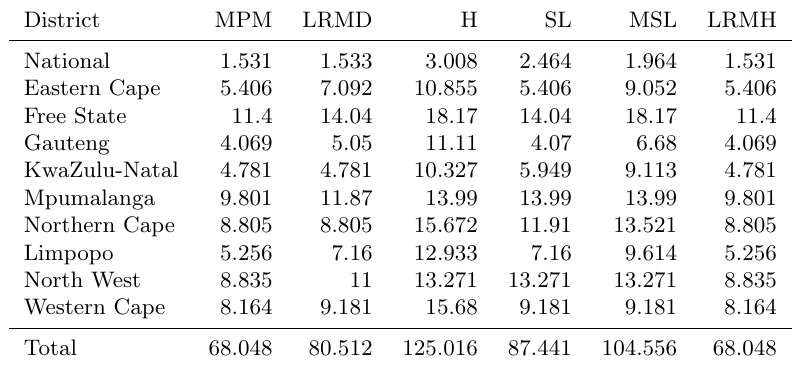
Table 7: Total absolute deviation for the allocation of seats using the mathematical programming models and the different allocation methods for the results of the South African election in 2004. For the abbreviations used refer to Table